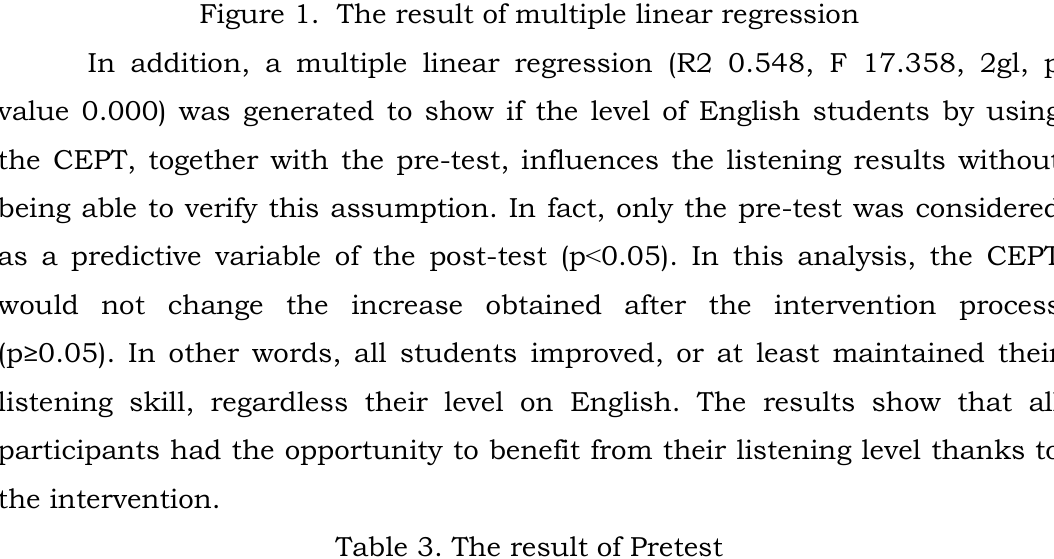
Figure 1. The result of multiple linear regression